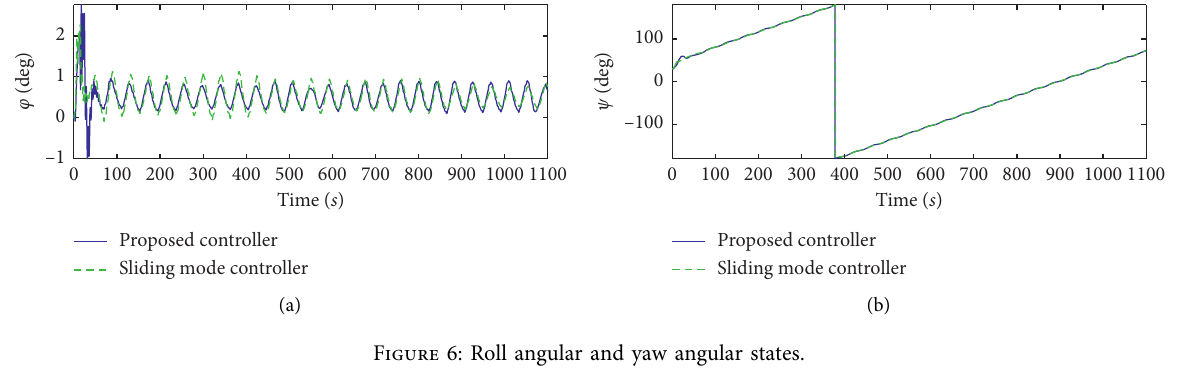
Figure 6: Roll angular and yaw angular